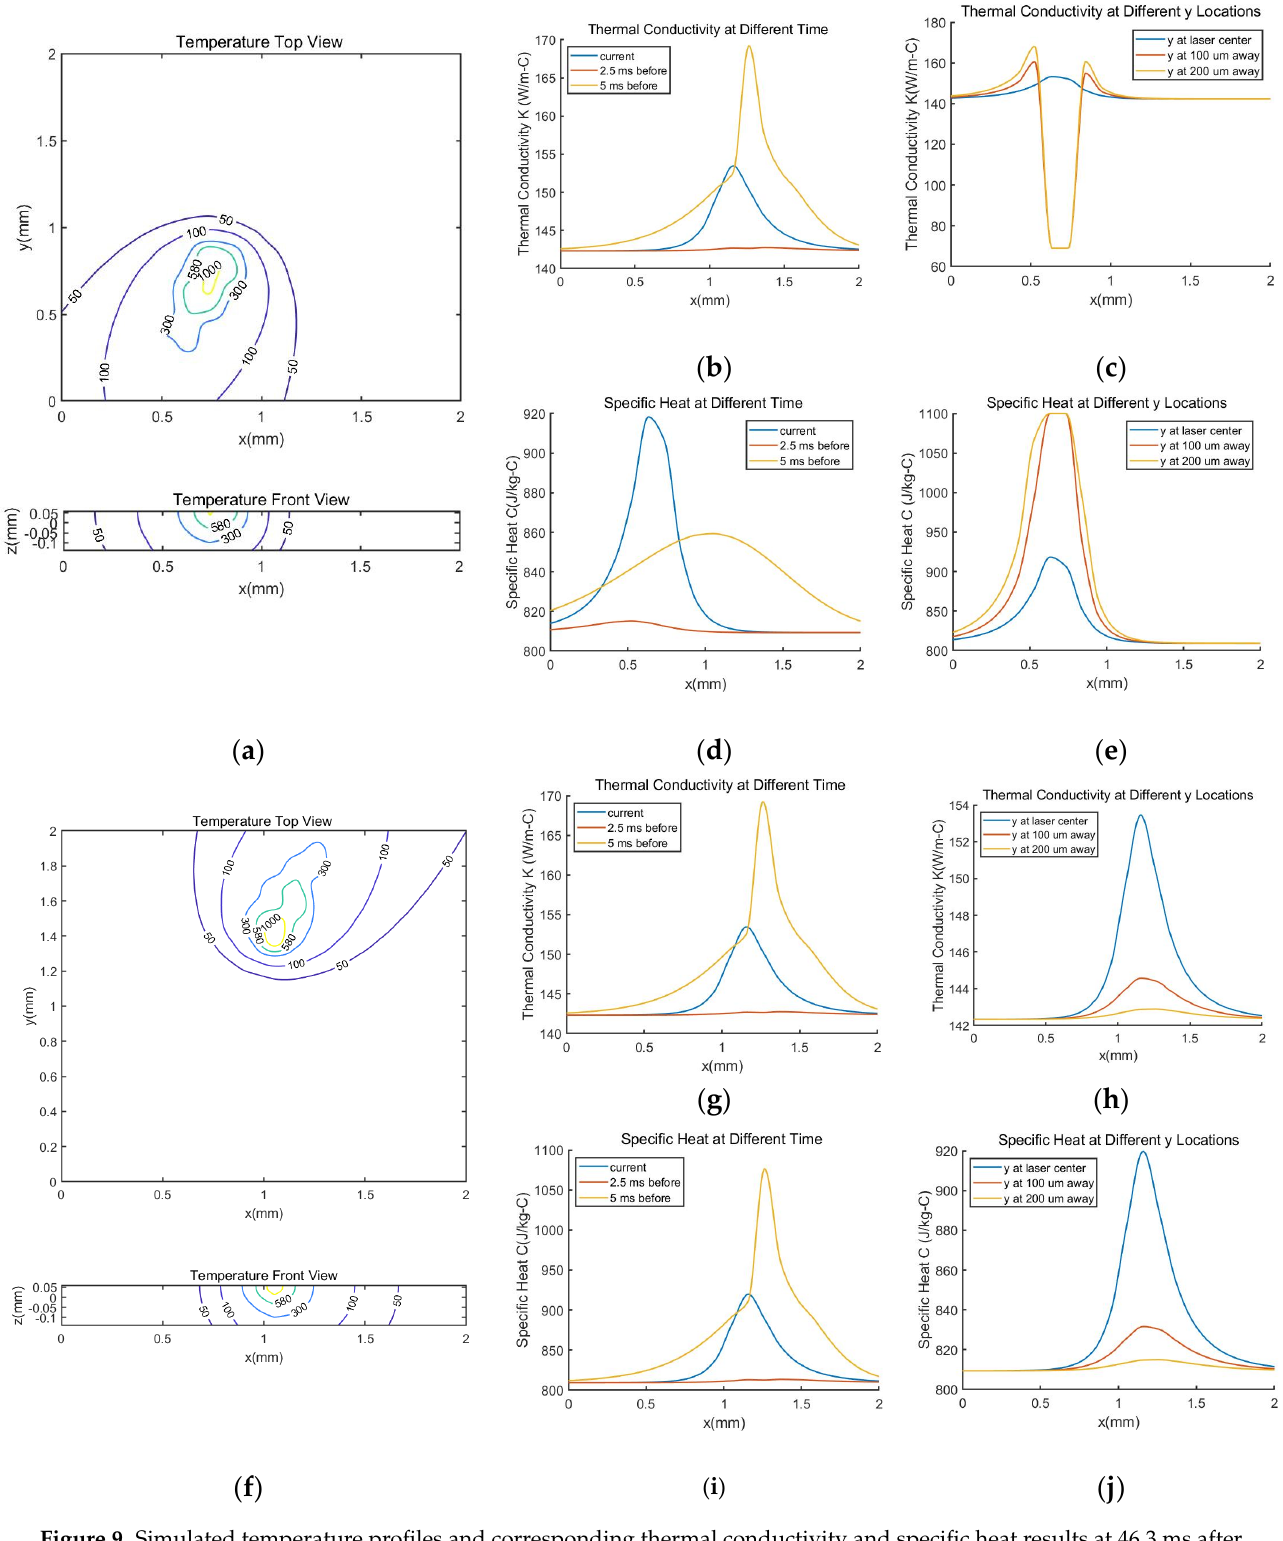
Figure 9. Simulated temperature profiles and corresponding thermal conductivity and specific heat results at 46.3 ms after the beginning of the scan. The applied laser power is 195 W, scan speed 700 mm/s, hatching space 0.17 mm and layer thickness 30 μ m. The rotation angle between two successive layers is 67 degrees. ( a – e ) are results for the unidirectional scan and ( f – j ) are results for the bidirectional scan.